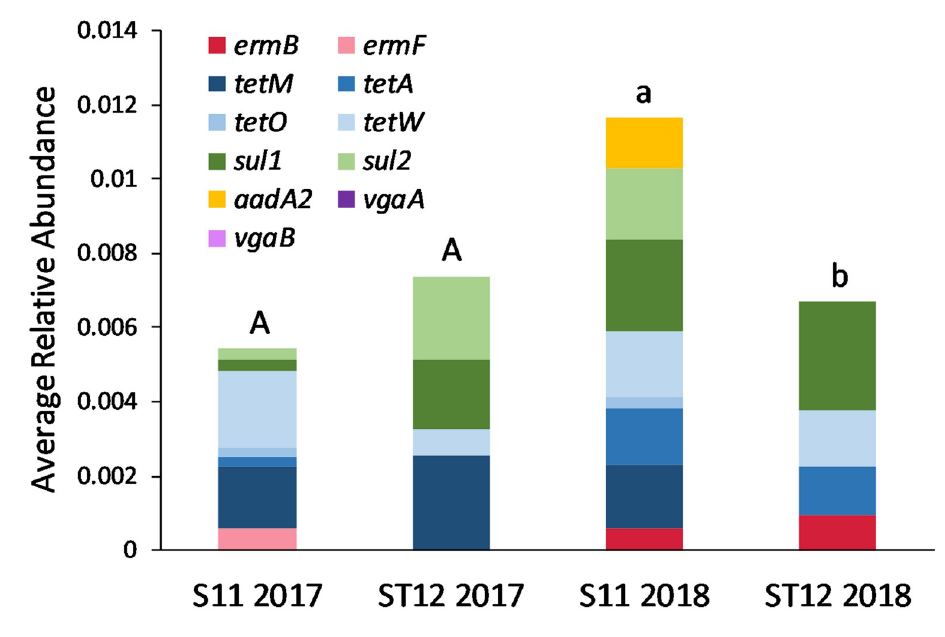
Fig 3. Average relative abundance from each ARG for the manure comparison. The letters above each plot represent total relative abundance significant differences based on the Wilcoxon Rank-Sum Test. Capital letters are associated with 2017 and lower-case letters are associated with 2018. Differing letters mean significant difference between